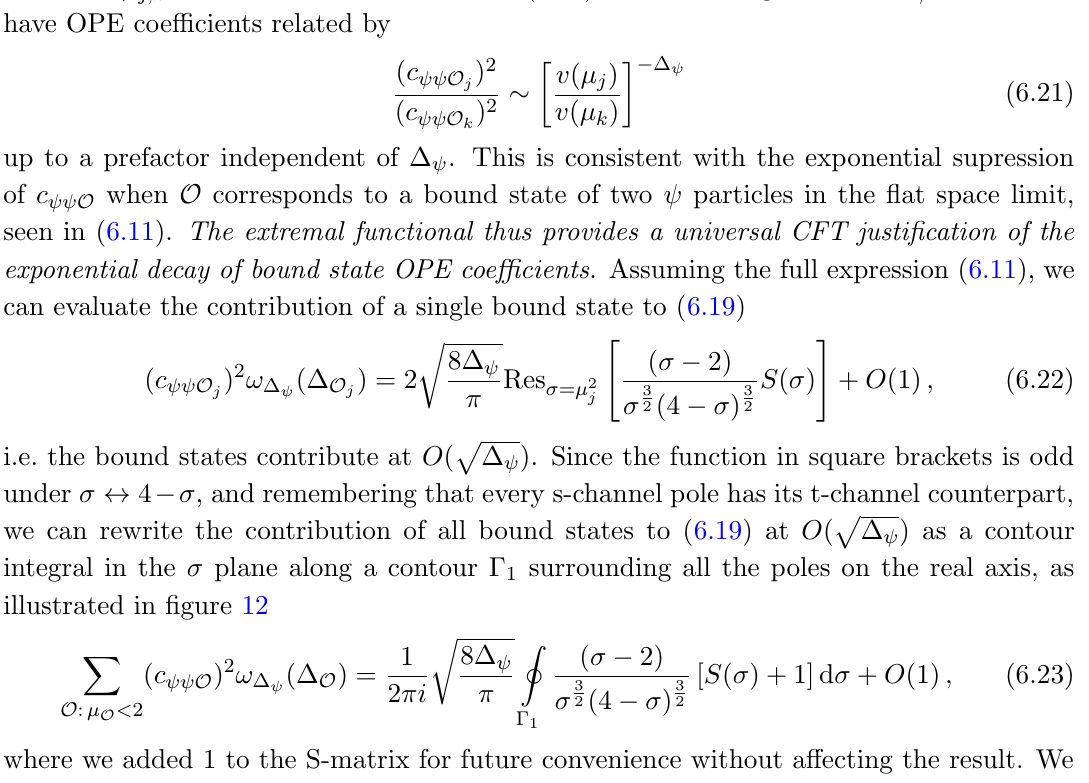
(cid:1) ( (cid:22) (cid:1) ) = 2) (cid:0) 1 ( (cid:22) 2 2) as (cid:0) (cid:0)